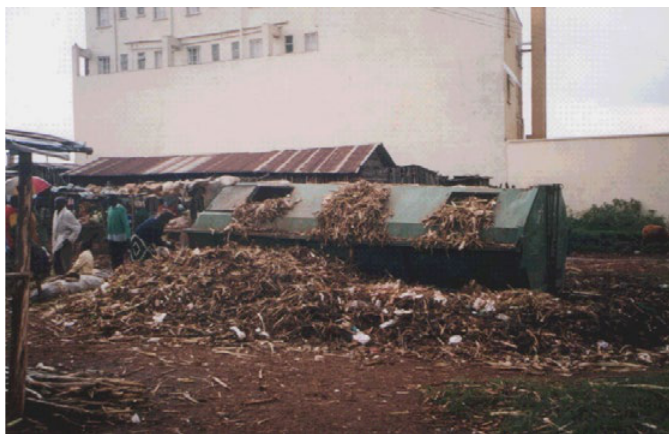
Fig. 4: An overflowing bulk storage container